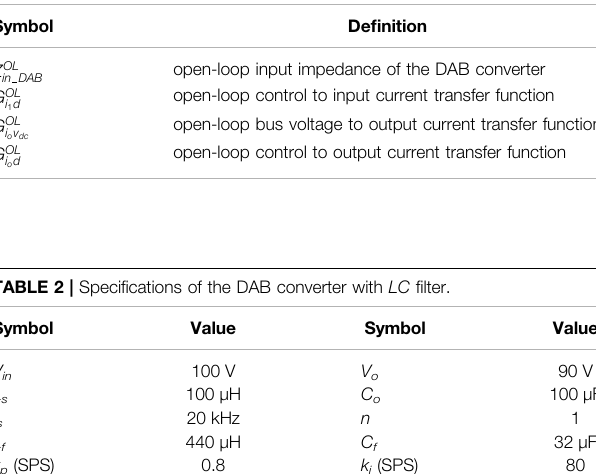
TABLE 1 | D e fi nitions for the transfer functions of the DAB .